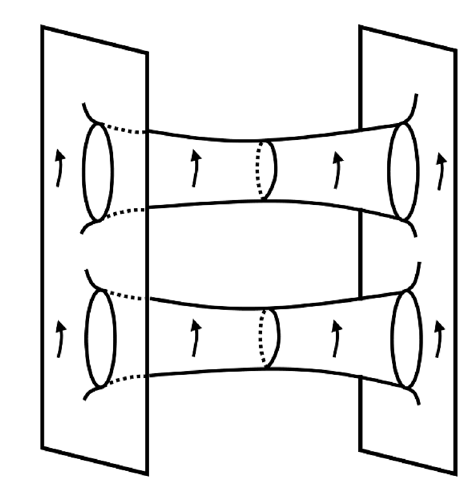
Figure 6 . A double wormhole between two asymptotically AdS universes. This geometry, which can be constructed from the solutions in the text, is dual to a pair of Higgsed Yang-Mills theories, with IR factors entangled pairwise between